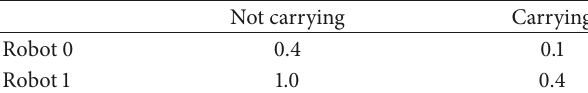
Table 3: Moving velocity.